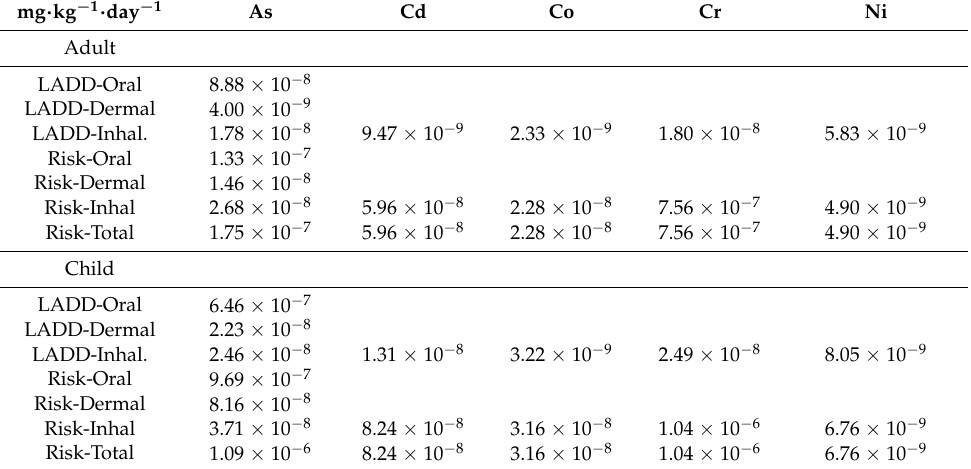
Table 5. Daily exposure amounts and Cancer Risk of metals in street dust to adult and child through three